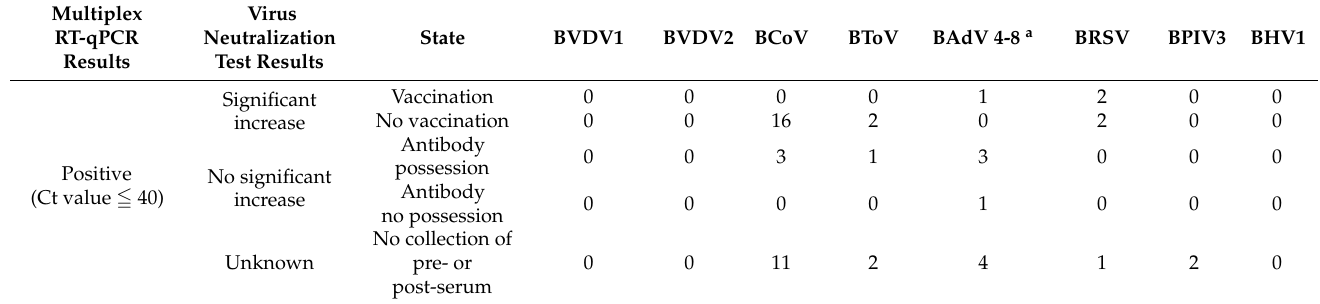
Table 4. A summary of combinations of positive results by multiplex real-time RT-PCR and a significant increase in antibody titers by virus neutralization test against bovine viral diarrhea viruses (BVDV1 and BVDV2), bovine coronavirus (BCoV), bovine torovirus (BToV), bovine adenoviruses (BAdVs), bovine respiratory syncytial virus (BRSV), bovine parainfluenza virus 3 (BPIV3), and bovine herpes virus 1